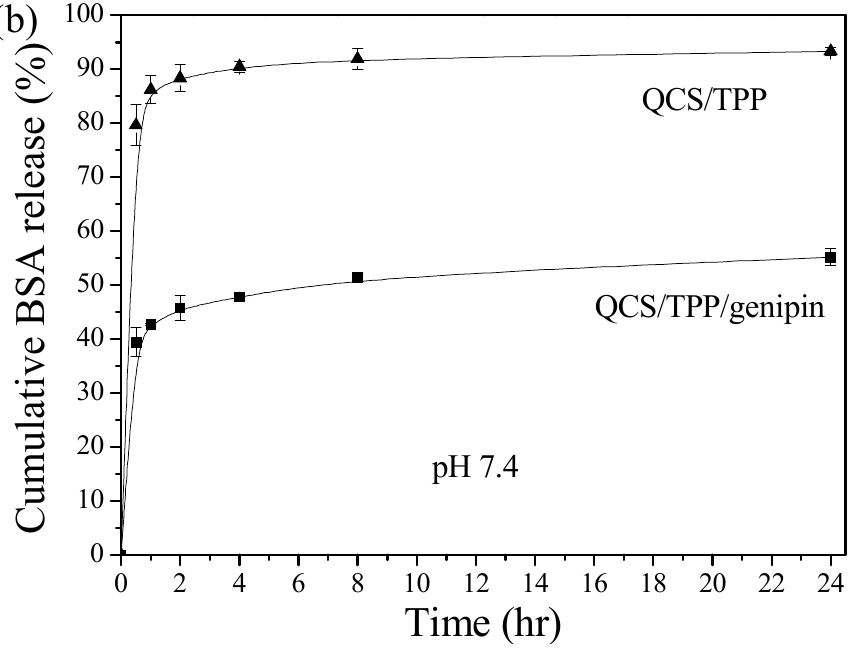
Figure 9. Release profiles of BSA from QCS nanoparticles cross-linked with (QCS/TPP/genipin; ■ ) or without (QCS/TPP; ▲ ) genipin at pH of ( a ) 1.2 and ( b ) 7.4 at 37 °C.